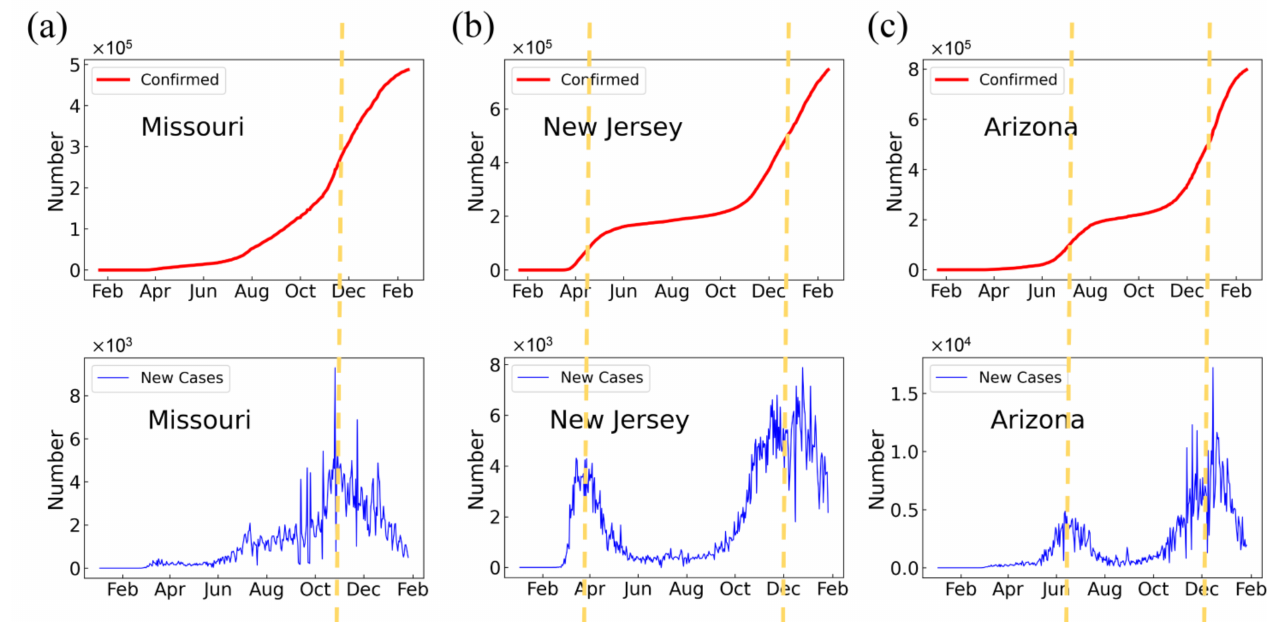
Figure 1. The daily confirmed cases (upper row) and corresponding new cases (lower row) of COVID-19 for three selected states: Missouri ( a ), New Jersey ( b ), and Arizona ( c ), in the US that represent three categories (one outbreak; two outbreaks, with first outbreak in March–April; and two outbreaks, with first outbreak in June–August, respectively) of transmission dynamics in the US, where the dashed yellow lines indicate the epidemic outbreak